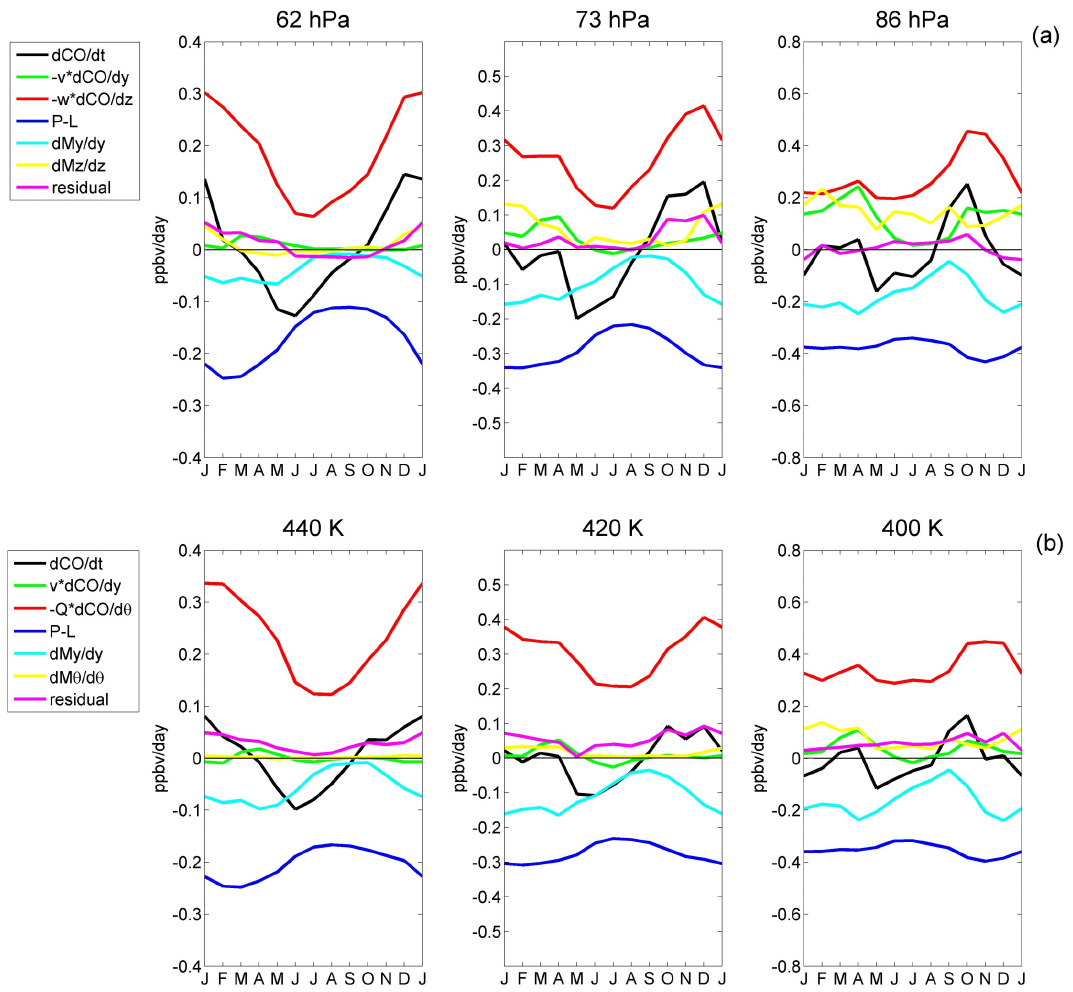
Fig. A2. Mean seasonal cycle (monthly means) of the terms in the CO continuity equation averaged over 18 ◦ S–18 ◦ N on pressure levels (Eq. 2, a ) and isentropic levels (Eq. 6, b